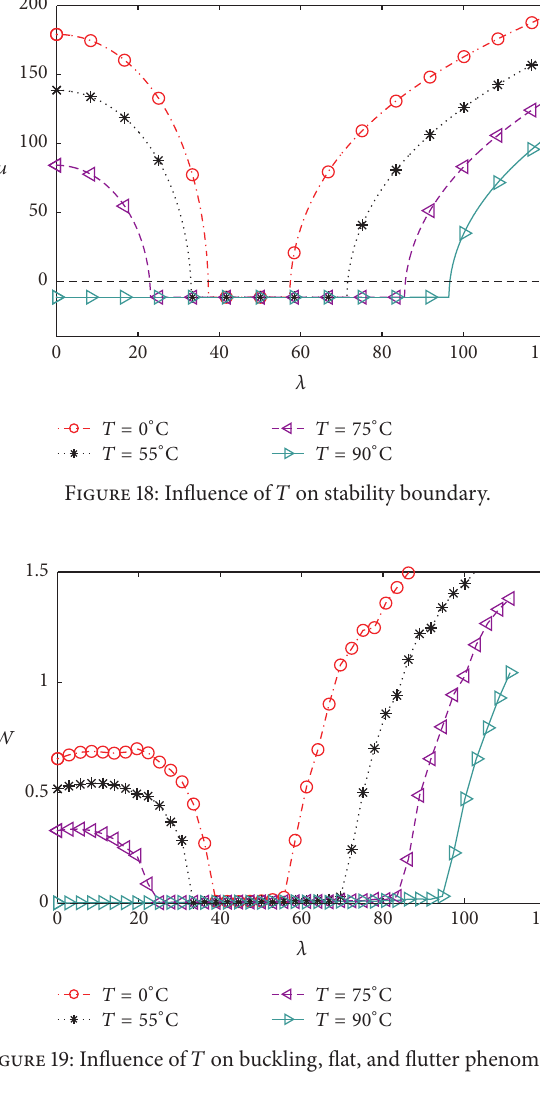
Figure 17: Influence of 𝑉 𝑠 on buckling, flat, and flutter phenomena.